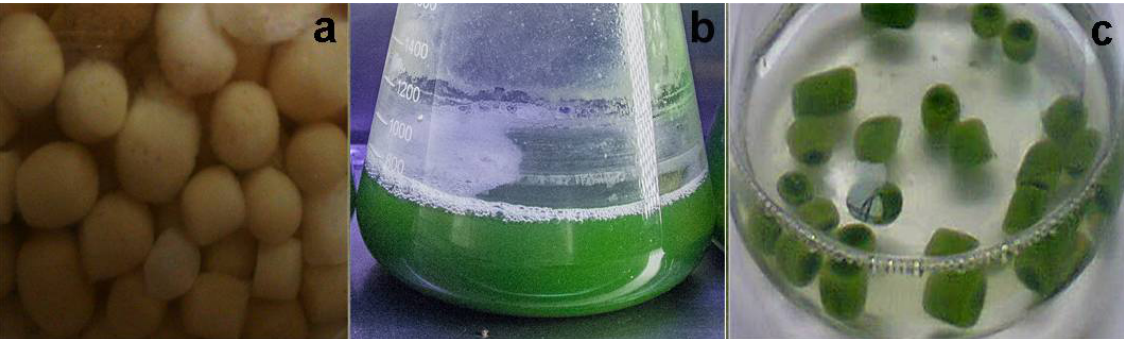
Figure 3. Photos of immobilized mycelial fungi of R. oryzae ( a ), and accumulating suspension of C.vulgaris cells ( b ) in the medium with the immobilized mycelial fungous cells, when the immobilized inoculum of microalgae C. vulgaris cells ( c ) are loaded into the same broth.